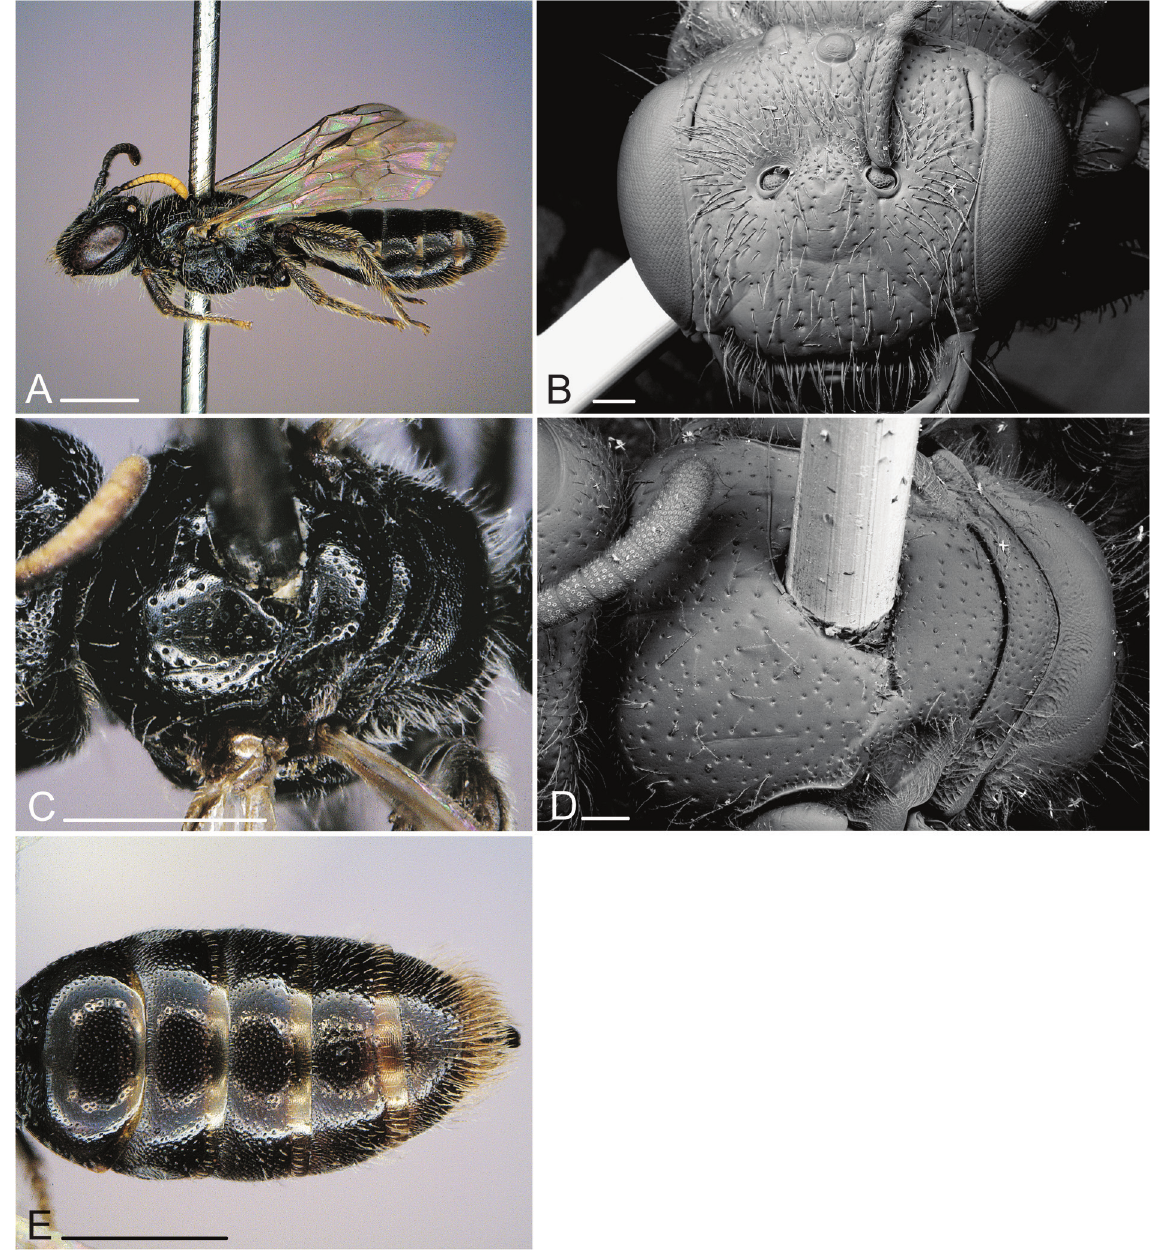
Fig. 23. Scrapter punctatus sp. nov., ♀. A . Lateral view. B . Head (SEM). C . Thorax (dorsal view). D . Thorax (dorsal view, SEM). E . Metasoma (dorsal view). Scale bars: photos: 1 mm, SEM: 0.1